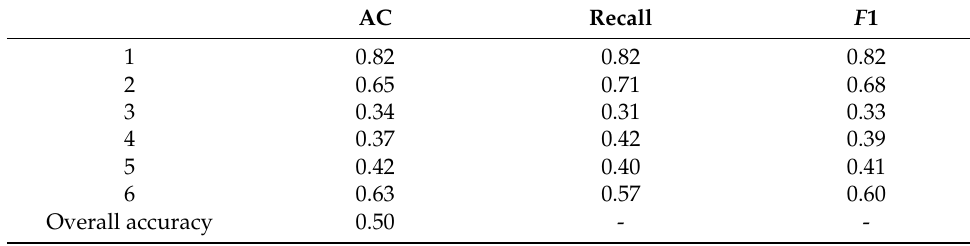
Table 6. Statistical results for the random forest